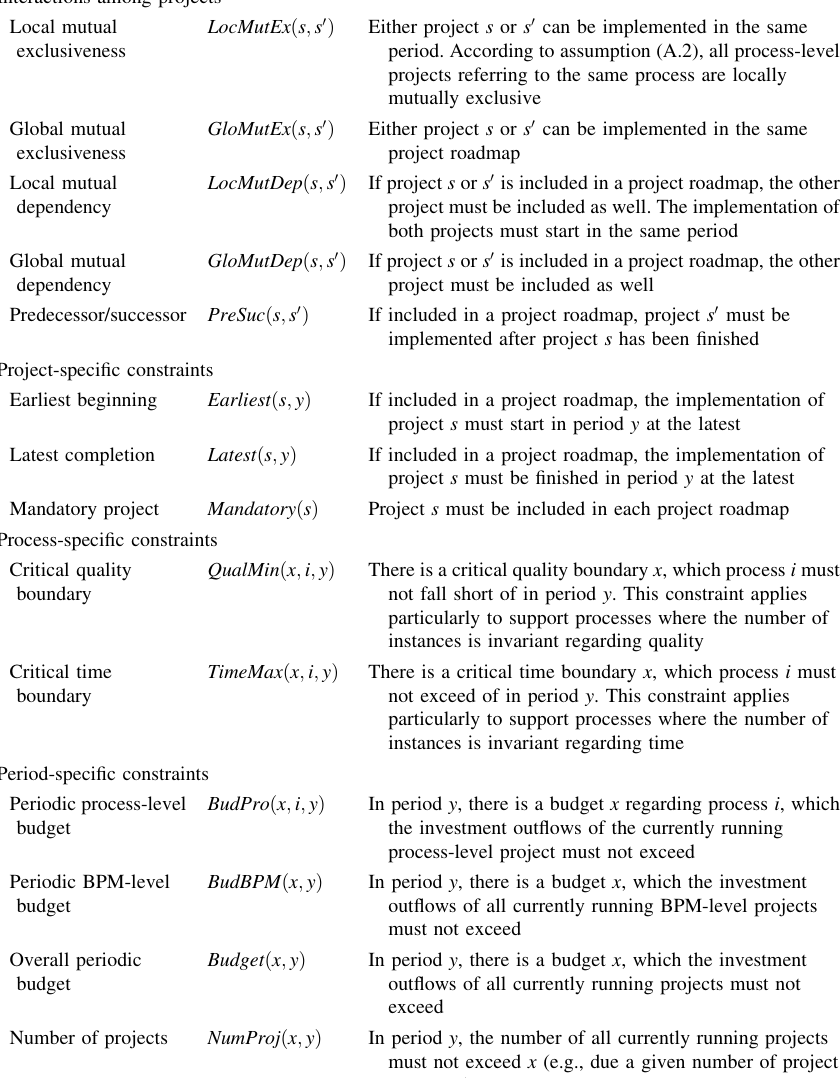
Table 1 Interactions among projects and domain-specific constraints Interactions among